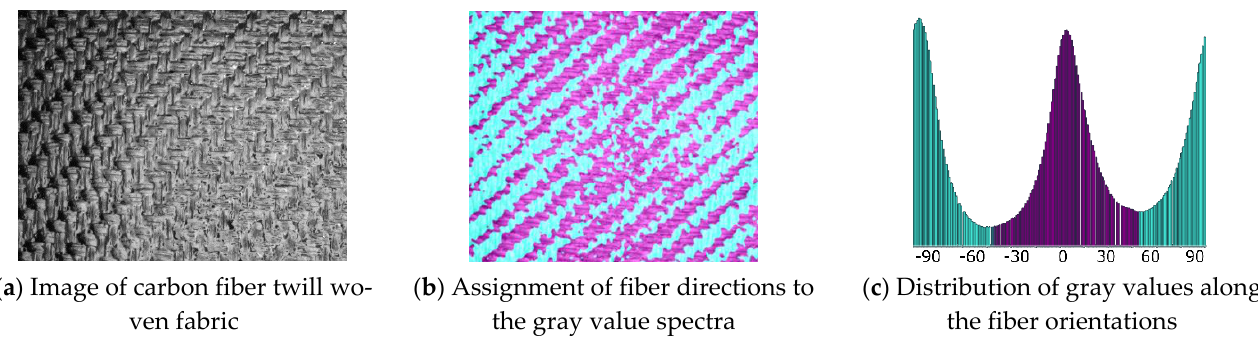
Figure 7. Material teaching and the assigning of fiber directions due to the gray value distribution. The results of the image capturing procedure are displayed in the Apodius desktop environment in real time, and blind spots can be identified. As an example, Figure 8 shows the use of the system.